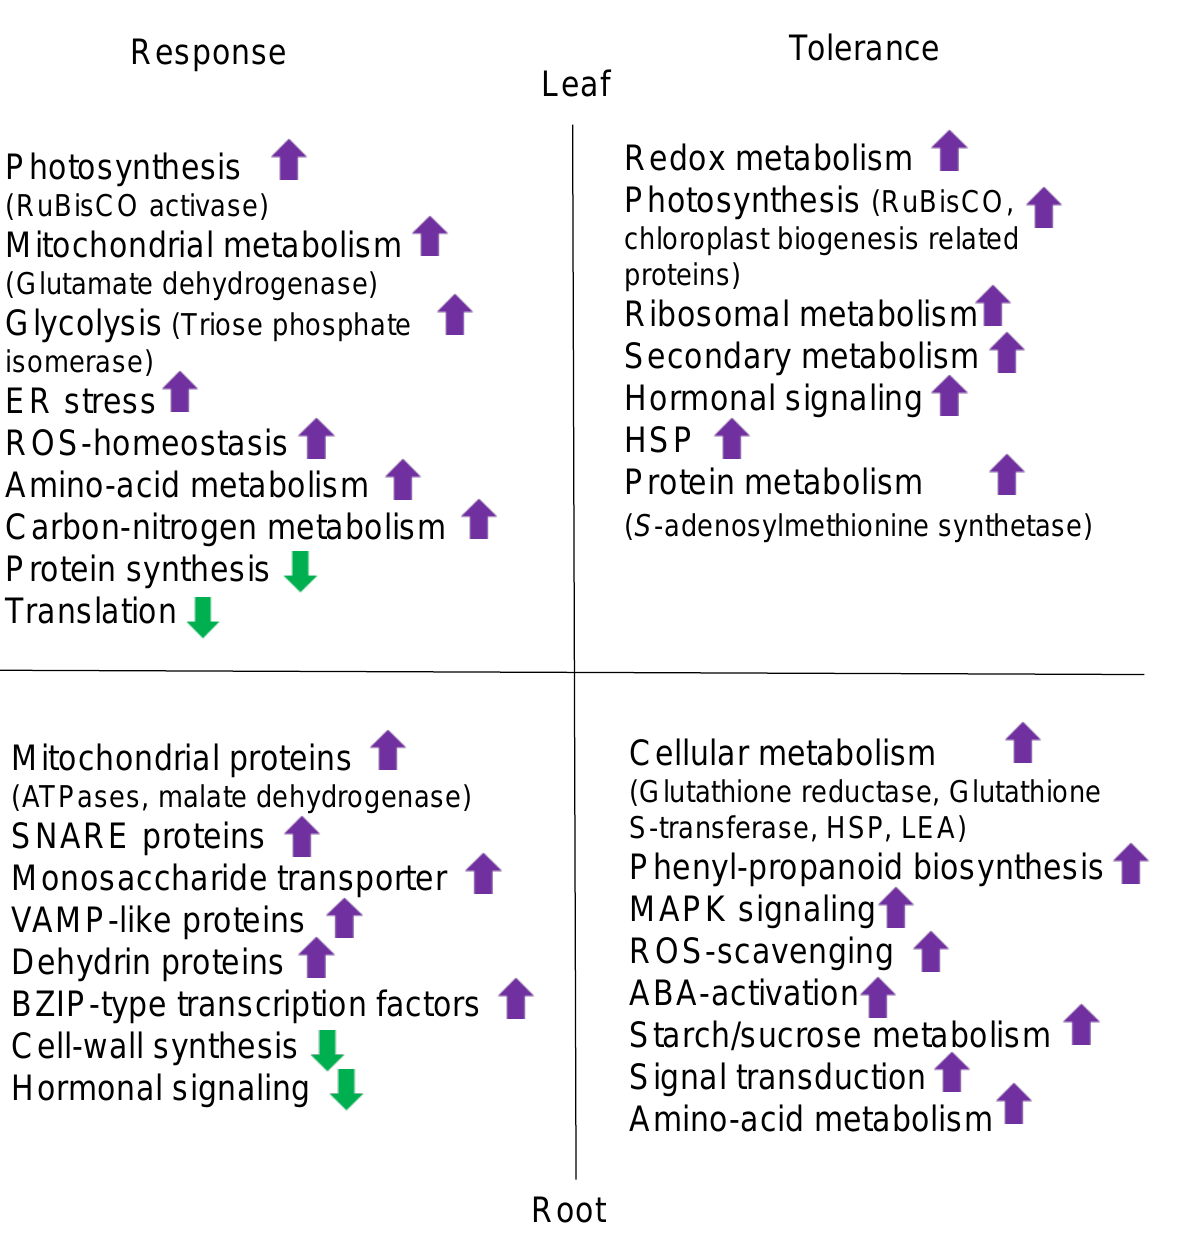
Figure 2. Salt stress response and tolerance mechanism in the leaves and roots of crops based on proteomics results. Upward and downward arrows show an increase and decrease, respectively, in morphological or physiological characteristics. Abbreviations: ABA, abscisic acid; ER, endoplasmic reticulum; ROS, reactive oxygen species; RuBisCO, ribulose bisphosphatase carboxylase/oxygenase; VAMP, vesicle-associated membrane protein; SNARE, soluble N-ethylmale-imide-sensitive factor- attachment protein receptors; HSP, heat shock protein; LEA, late embryogenesis abundant protein; BZIP, basic leucine zipper; MAPK, mitogen-activated protein